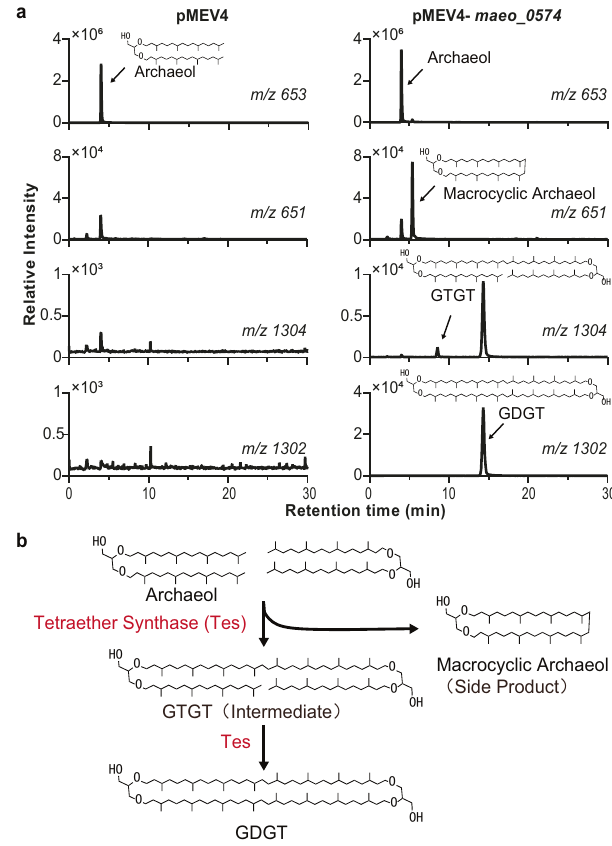
LC-MS extracted ion chromatograms of acid hydrolyzed extracts from heterologous expression strains showing that Tes ( maeo_0574 ) can generate not only GDGT, but also the potential biosynthetic intermediate GTGT, and the side product macrocyclic archaeol. b Proposed GDGT biosynthesis pathway based on the Tes heterologous expression products. The chromatograms of all Tes homologs expression strains are shown in Supplementary Fig. 2, and mass spectra are shown in Supplementary Fig. 1. Notice that the double bonds on archaeol may be required for the condensation reaction (see discussion). Source data are provided as a Source Data fi